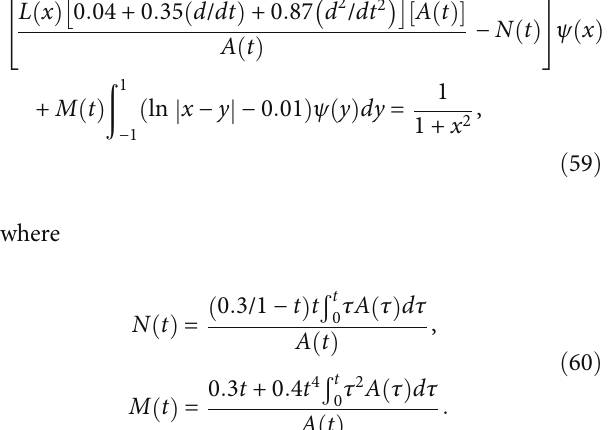
, where g ð x Þ = L